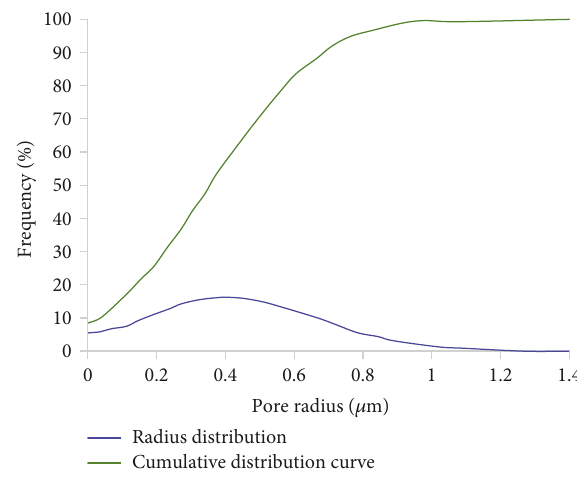
Figure 2: Schematic of Gauss